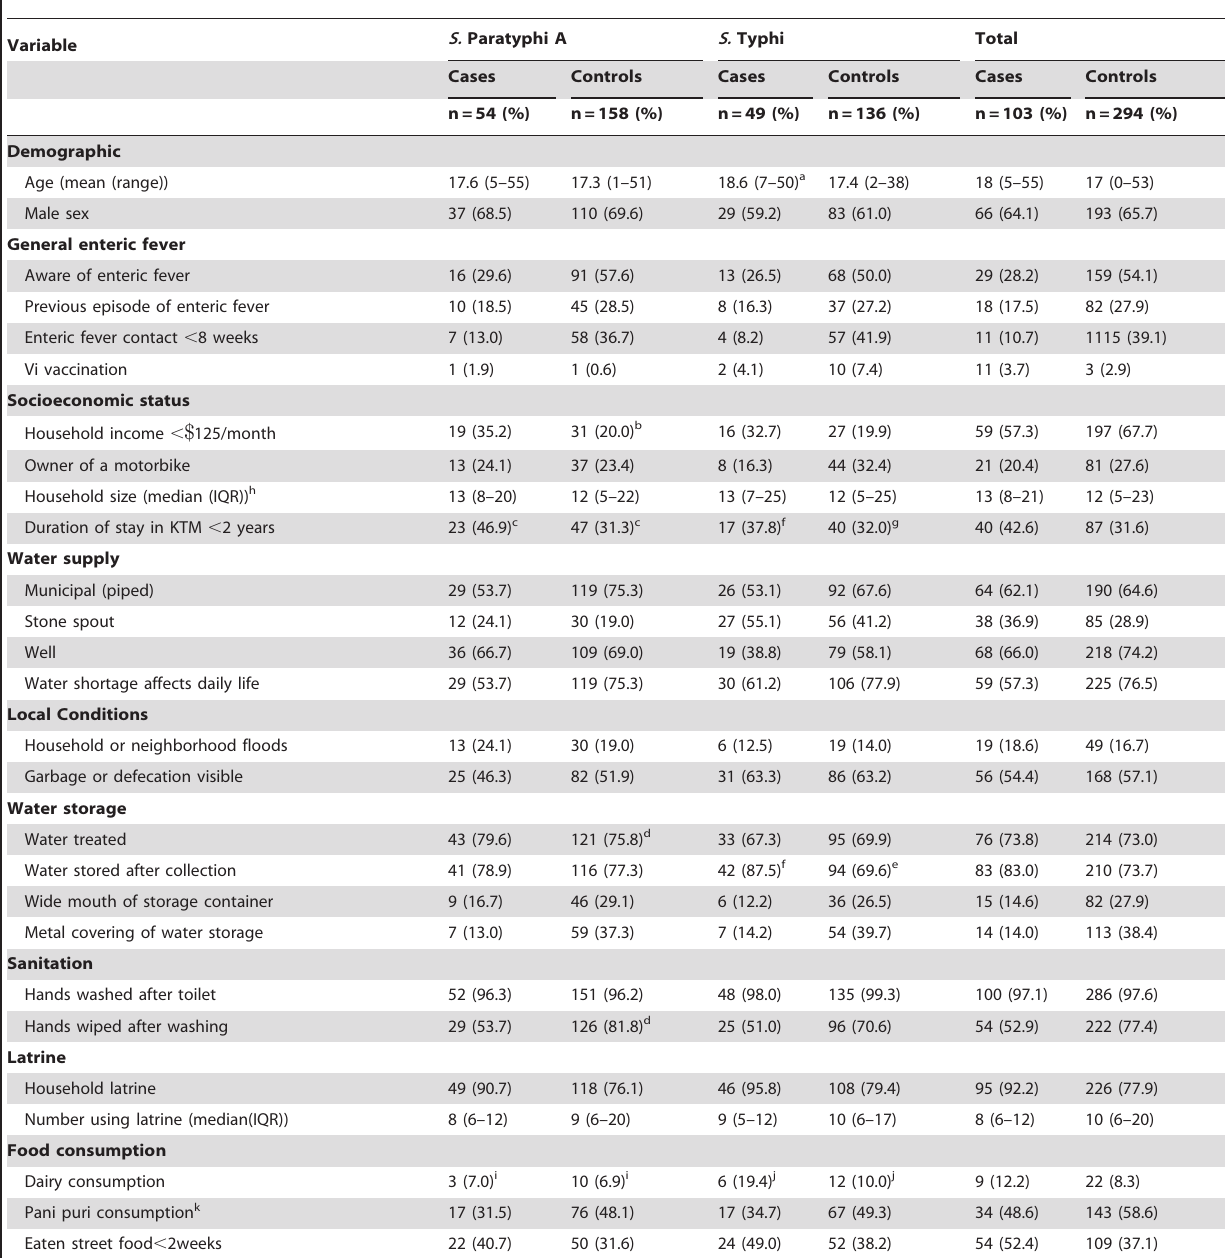
Table 1. Baseline characteristics from S. Paratyphi A and S. Typhi cases and matched controls in Kathmandu, Nepal, 2011.